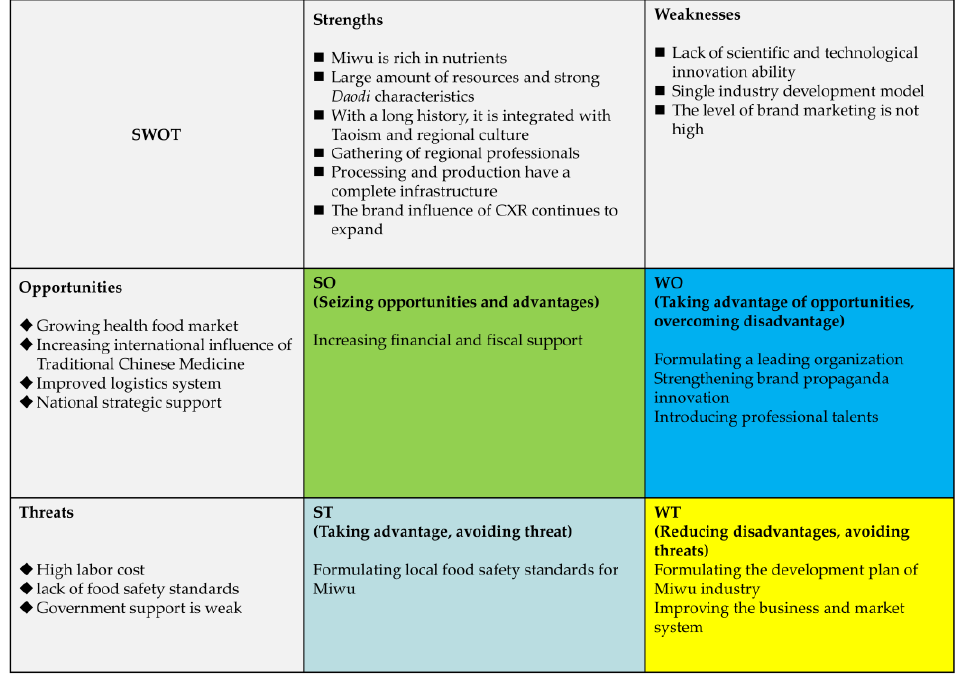
Figure 4. SWOT analysis of the Miwu industry.